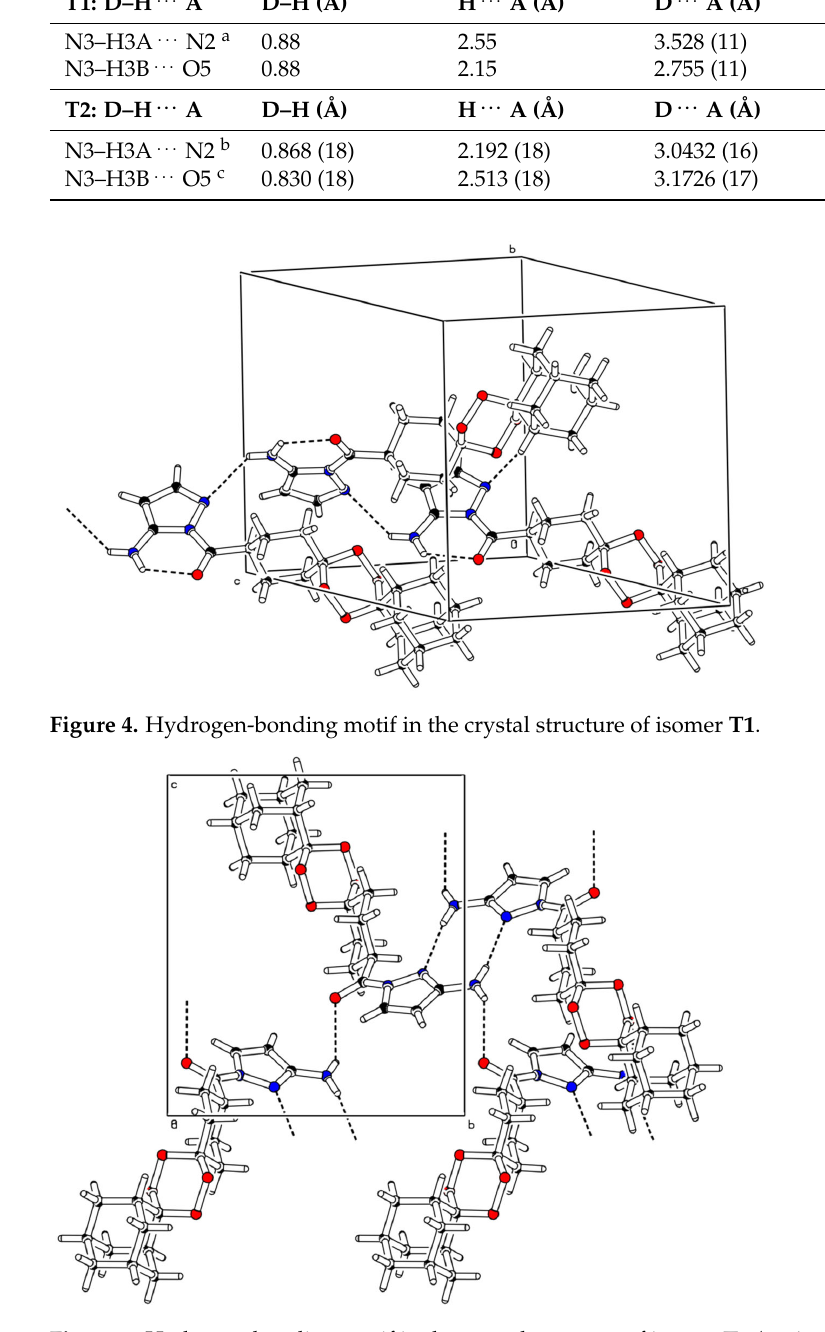
Figure 5. Hydrogen-bonding motif in the crystal structure of isomer T2 (projection along the crystallographic a ‐ axis).